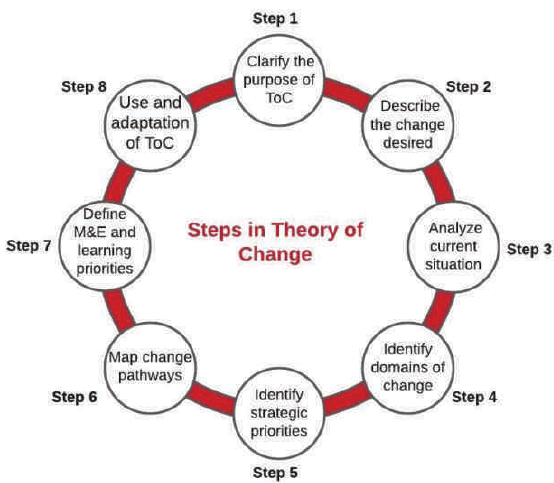
Figure 1: Eight steps in developing a theory of